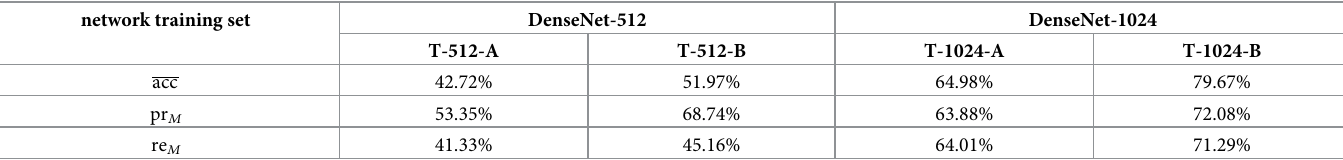
Table 4. Evaluation